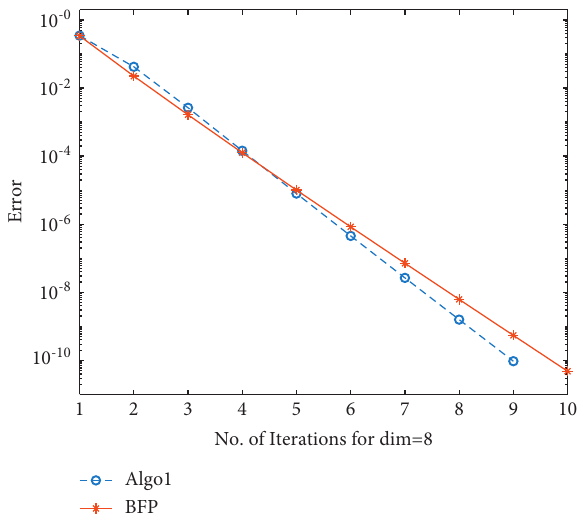
Figure 12: Iteration no. vs error for dimension 8.